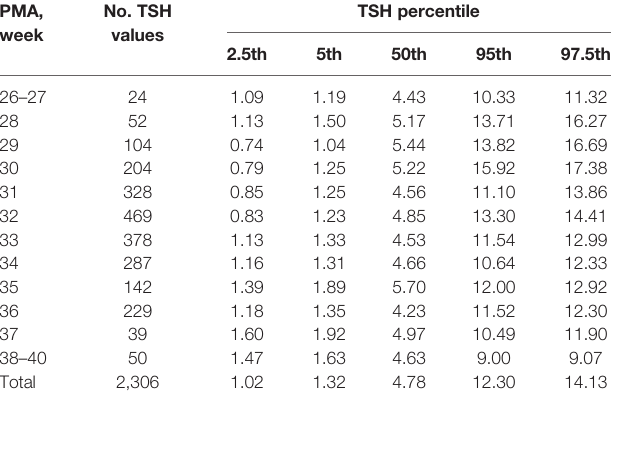
TABLE 3 | Percentiles of FT4 values (pmol/L) based on different PMA in preterm infants with GA < 32